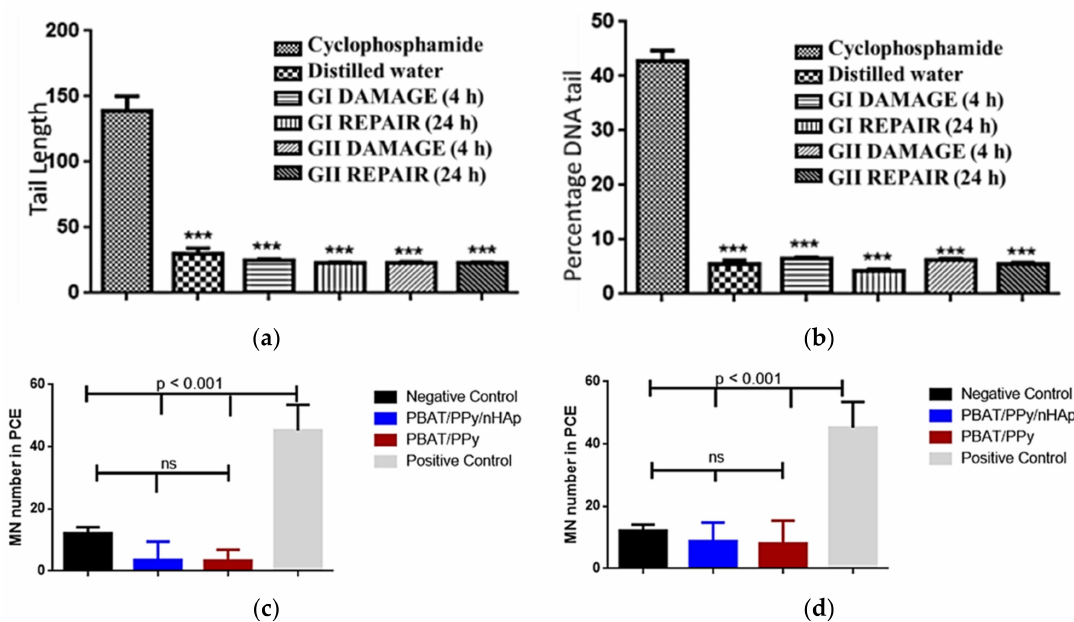
Figure 5. No in vivo genotoxic effects of the PBAT/PPy/nHAp scaffold were detected. ( a ) Tail length and ( b ) percent DNA tail of comet assay of the animals after exposure. Mean of micronuclei found after ( c ) acute (after 48 h) and ( d ) chronic (after 72 h) exposure of the animal to the scaffold. Legend: cyclophosphamide = positive control; distilled water = negative control; GI = PBAT/PPY/nHAp; GII = PBAT/PPy; ***: p < 0.001